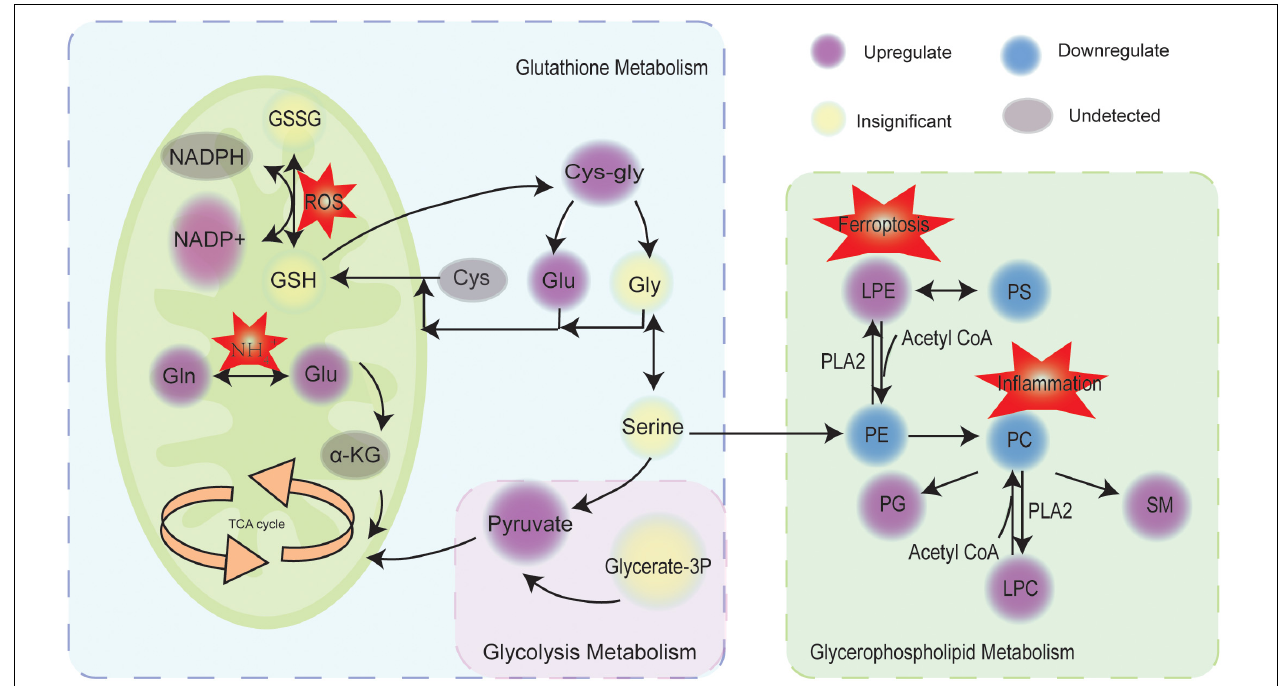
FIGURE 5 | Scheme of perturbed metabolic and lipidic pathways in placenta of preeclampsia. Circles marked in purple, blue, yellow, and gray represented the upregulation, downregulation, insignificance, and undetected, respectively. GSH, glutathione; GSSG, glutathione disulfide; ROS, reactive oxygen species; Gln, glutamine; Glu, glutamate; TCA, tricarboxylic acid cycle; α -KG, α -ketoglutaric acid; Cys, cysteine; Gly, glycine; Glycerate-3P, 3-phospho-D-glycerate; PS, phosphatidylserines; PE, phosphatidylethanolamines; PC, phosphatidylcholines; PG, phosphatidylglycerol; SM, sphingomyelin; LPE, lysoPE; LPC, lysoPC; PLA2,